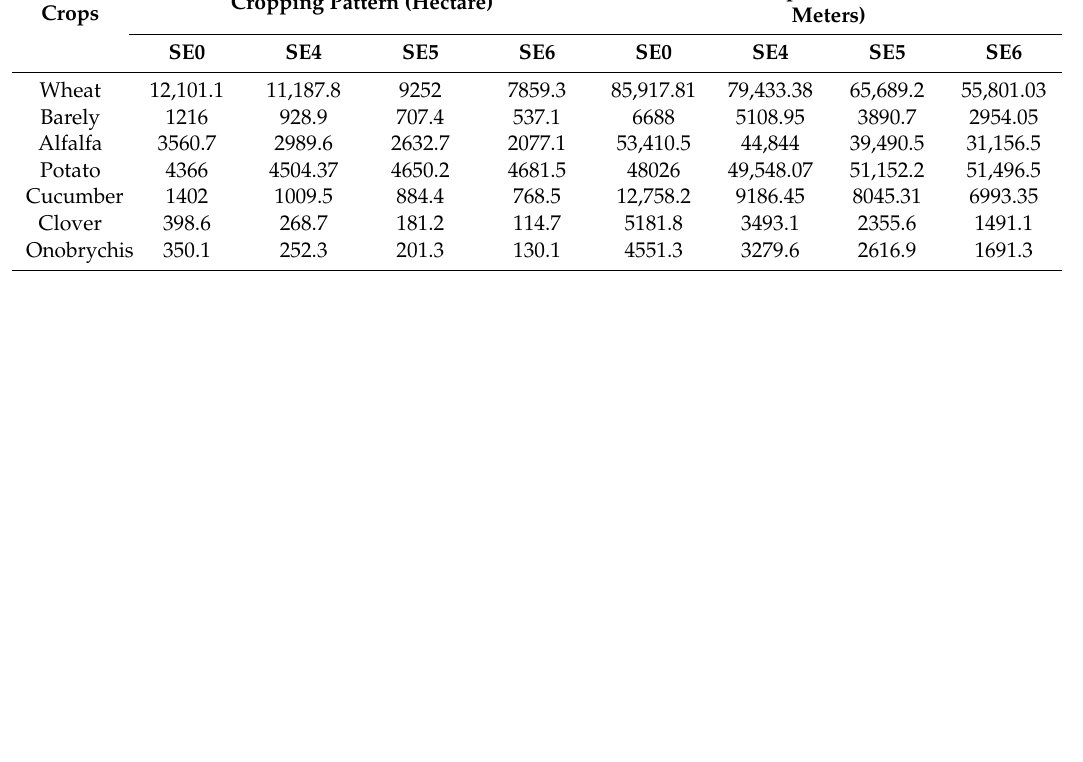
Table A2. The e ff ect of groundwater quota scenarios on cropping pattern and consumed water level. Crops